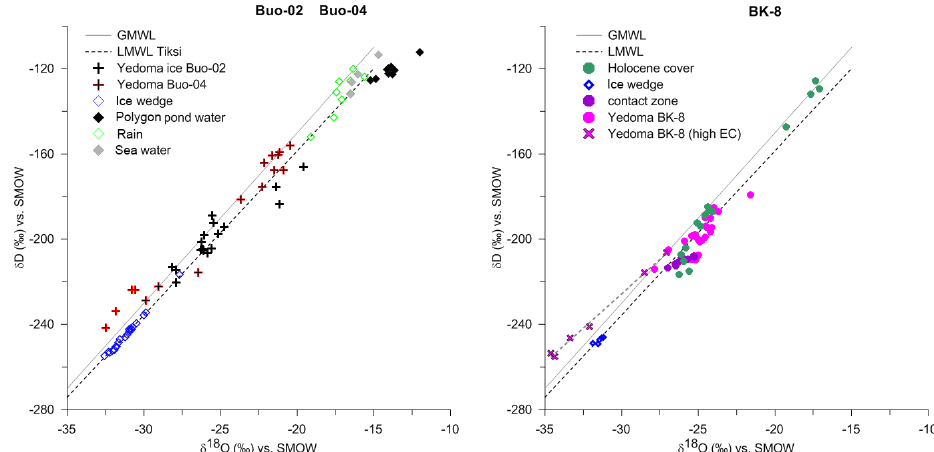
Figure 12. Stable isotope ratios for the Buo-02 and Buo-04 exposures and the BK-8 core samples. For reference, they are plotted together with precipitation and meteoric water lines, both global (GMWL; solid line) and local (LMWL; dashed line).